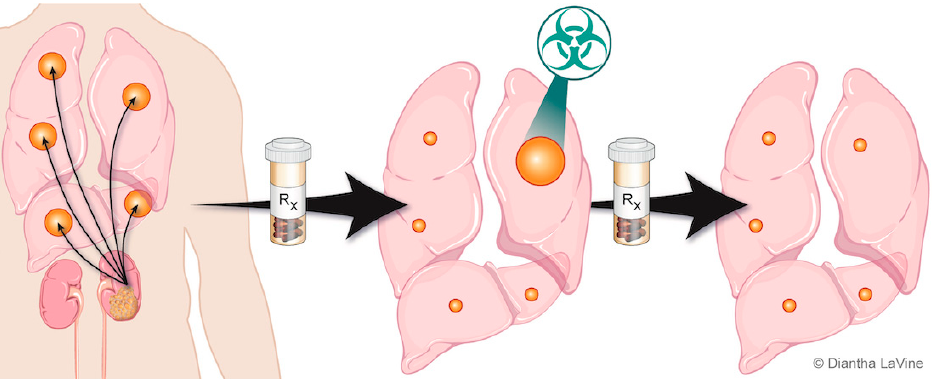
Figure 2. Depiction of oligoprogressive metastatic RCC. The metastatic disease is treated with systemic therapy and has a favorable response except at limited site(s). The limited progressive disease can be targeted with radiation therapy (SAbR), which provides durable control so the patient can remain on the same systemic